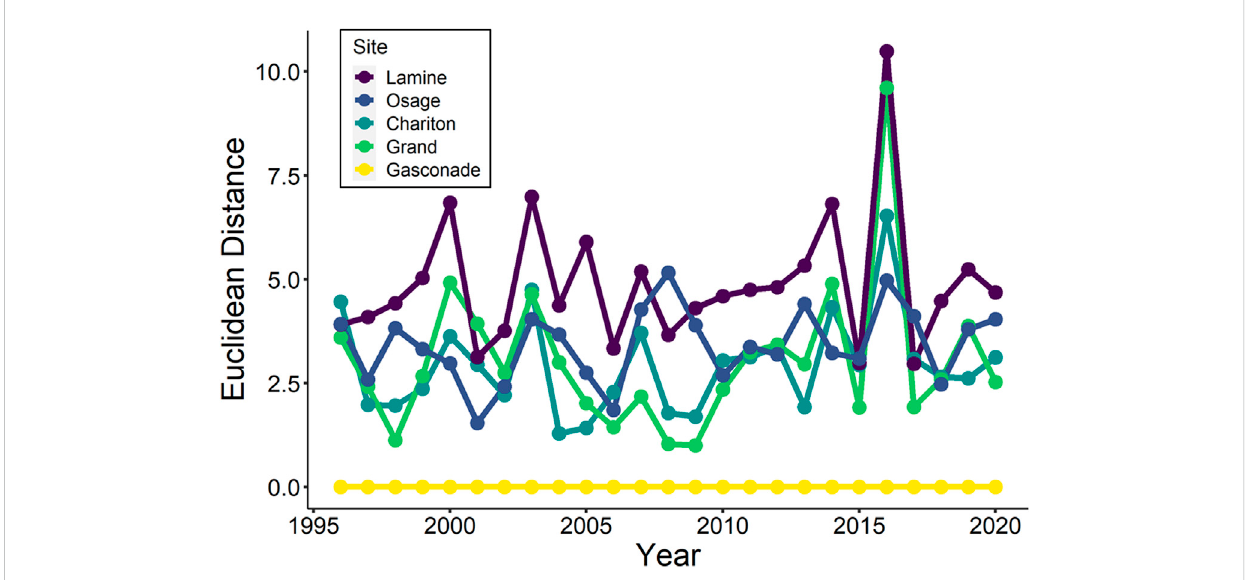
FIGURE 2 Multivariateindicatorsofannualhydrologicregime(Arch fi eldetal.,2014)correctedforwatershedareaof fi vemajortributariestothelowerMissouri River (i.e., mean, CV, skewness, kurtosis, AR1 correlation, amplitude, and phase). The plot illustrates how interannual variability in relatively fi ne-scale environmental processes can determine which tributaries are most hydrologically similar to the unregulated Gasconade River, that serves as the reference line in this